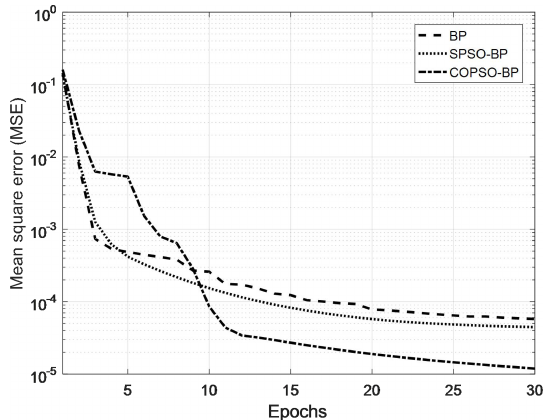
Figure 10. Comparison of mean square error curves.